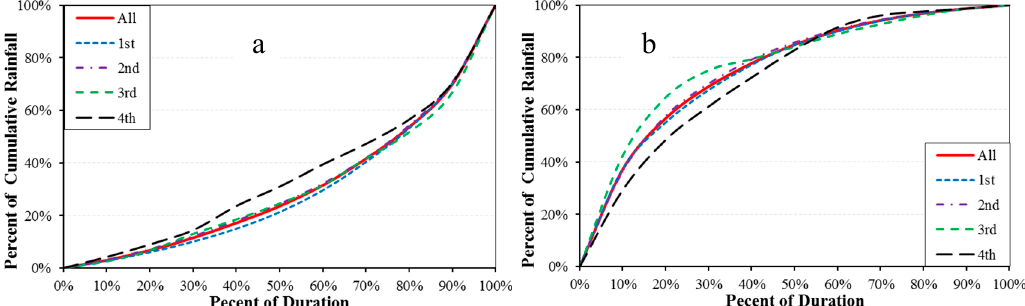
Figure 3. The Huff curves for the rising ( a ) and falling ( b ) limbs at a probability of 50% by all storm events and by those within the four quartiles at Site 2.